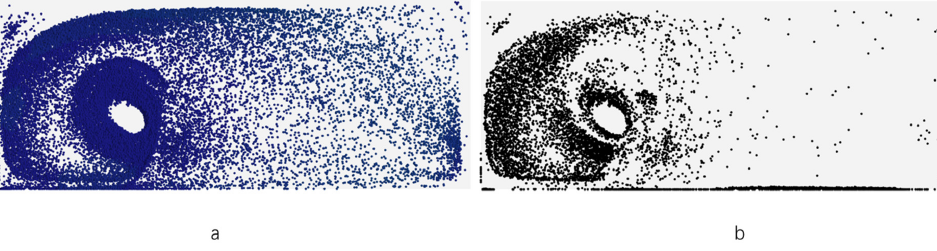
Figure 29. Location and collision of particles in c1: ( a ) Location of particles; ( b ) Collision of particles.